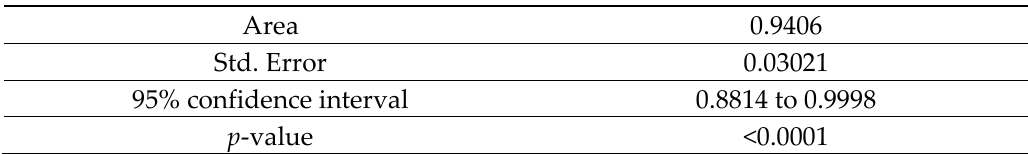
Figure 6. ROC curve for Gal-3 (2008 and 2013).